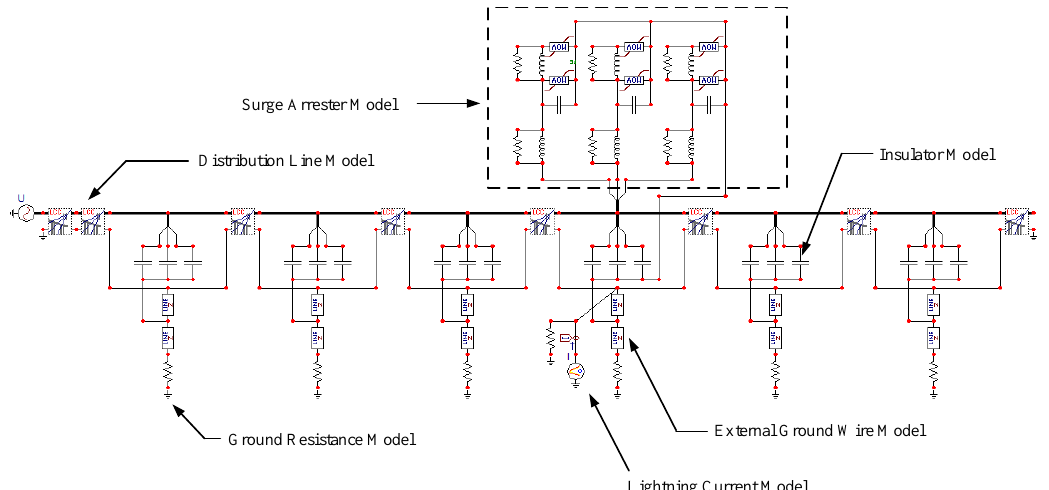
Figure 6. Simulation model in the Alternative Transients Program/Electromagnetic Transients Program (ATP/EMTP). Table 4. Parameters used for the design.